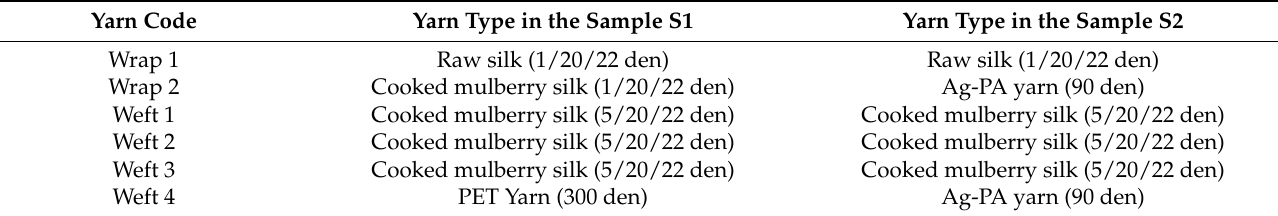
Table 2. Details of the yarns for Song Brocade fabric.